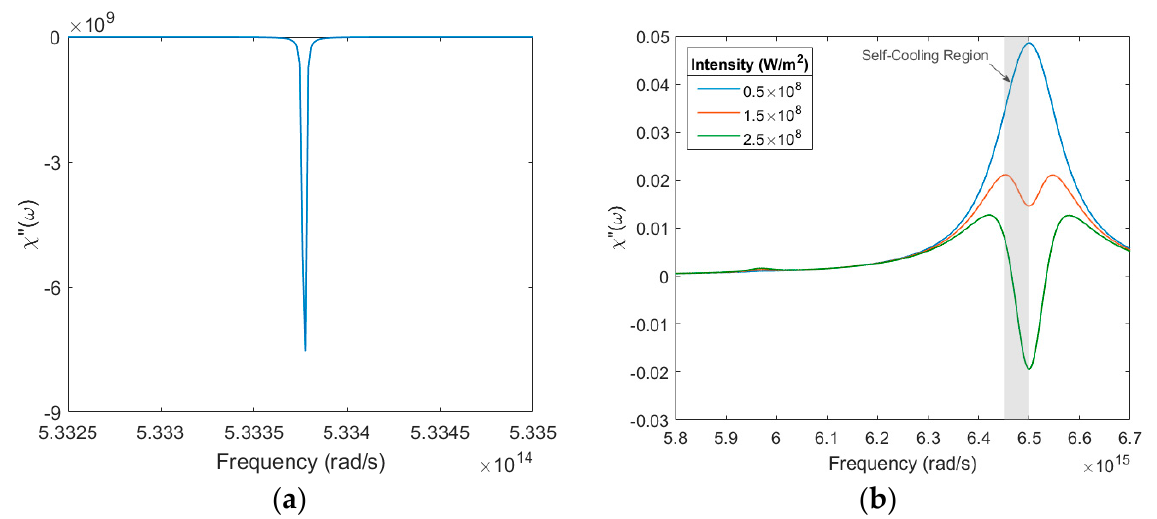
Figure 16. Plots of optical absorption versus frequency in a 3-level system modeled after Ce 3+ :LiCaAlF 6 showing ( a ) a gain feature on the low frequency transition at ω 13 for an intensity of I = 0.5 × 10 8 W/m 2 and coupling parameter V / (cid:125) = 10 8 rad/s and ( b ) the two short wavelength transitions of Ce 3+ at low-, medium-, and high-intensity, with V = 0. Negative absorption indicates gain without population inversion as the populations of states 1 and 3 exceed that of state 2 at all intensities. The shaded spectral region at red detunings within a linewidth of the ω 12 transition illustrates the range over which self-cooled LWI may be possible.